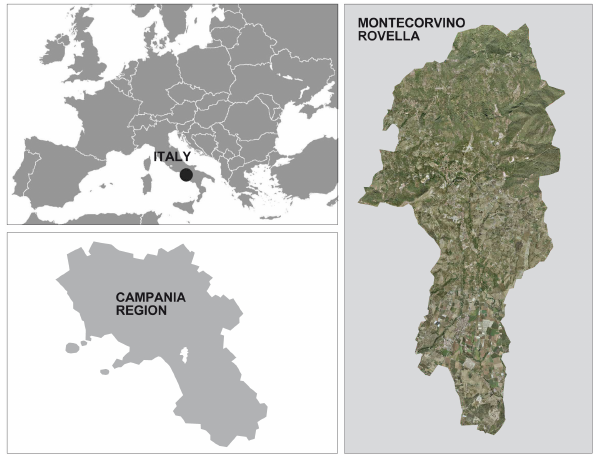
Fig. 1. Location of Montecorvino